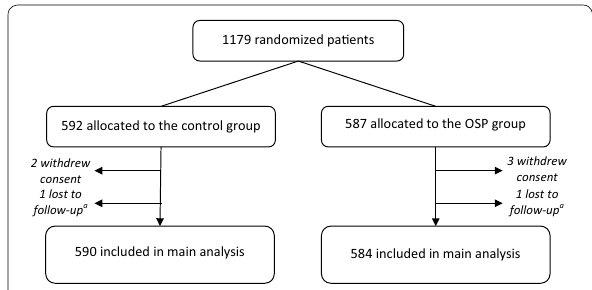
Fig. 2 Flowchart. a Patients lost to follow-up: imputation of missing data (alive vital status) was performed. OSP, oversedation